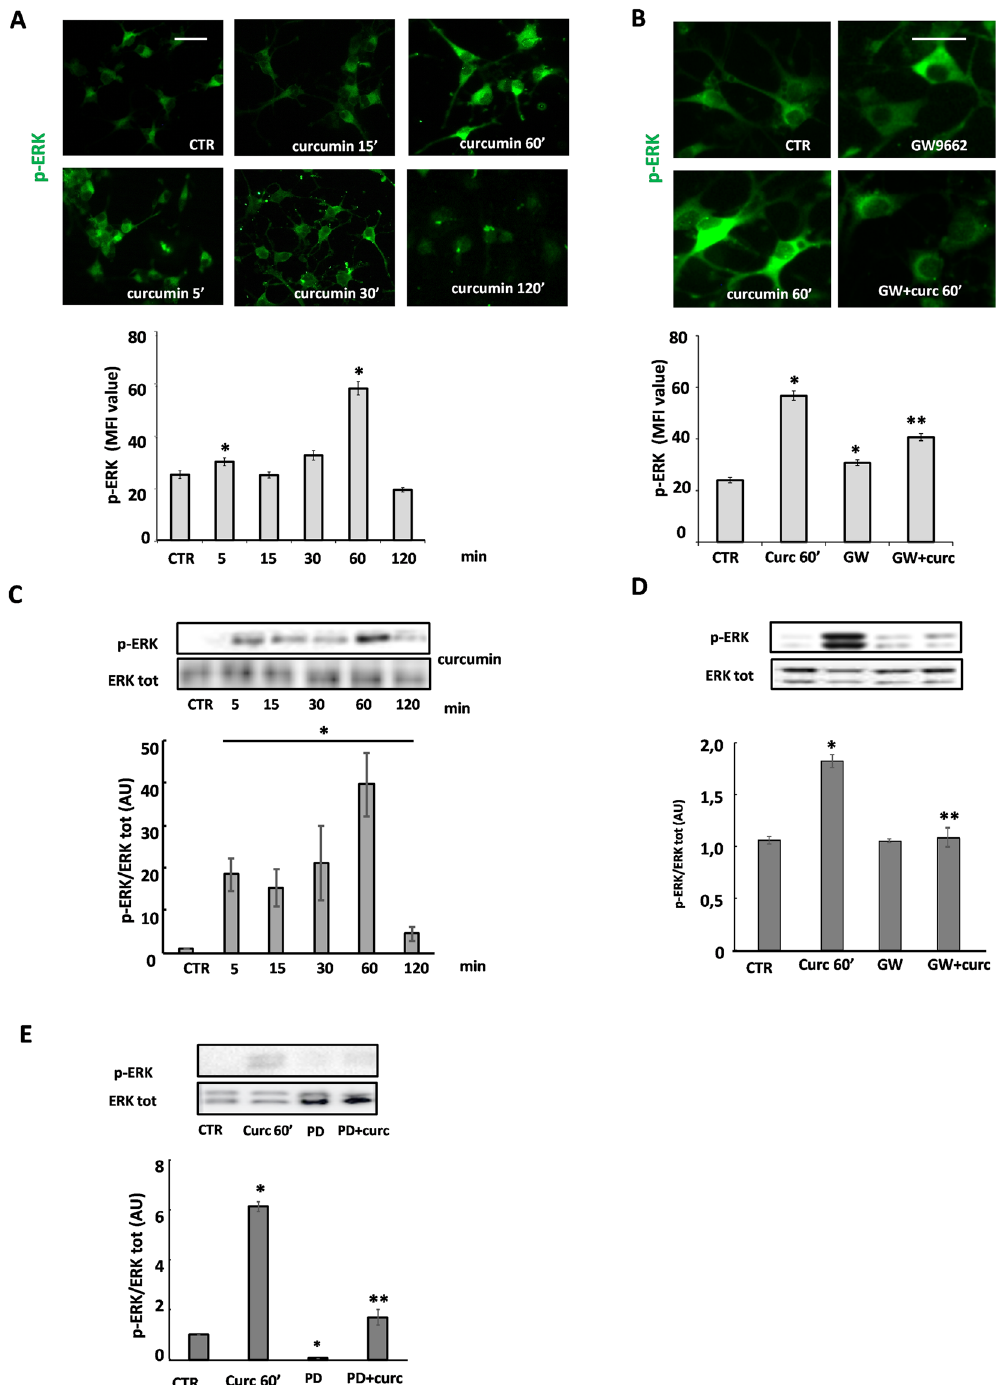
Figure 2. Curcumin modulates phosphorylation of ERK by involving PPAR-γ activation. Immunofluorescence and western blot analysis of the time-course of 1 µM curcumin-induced ERK 1/2 phosphorylation are shown in ( A ) and ( C ). Representative photomicrographs of p-ERK immunofluorescence are shown in panel A, at the indicated time points. The upper panel in C shows a representative western blot of p-ERK and total ERK. To confirm the ERK 1/2 activation by curcumin (curc), OPs were pretreated for 30 min with 10 μM PD98059 (PD; ERK1/2 inhibitor) and p-ERK was evaluated by western blot ( E ). To evaluate the involvement of PPAR-γ in curcumin-induced ERK1/2 activation, OPs were pretreated with 1 μM GW9662 (GW; PPAR-γ antagonist; B and D ). p-ERK was evaluated by IF (MFI value is shown in the lower panel in B . Data are mean ± SEM of n. 300 cells for condition) and by western blot (panel D ; Data are means ± SEM of three